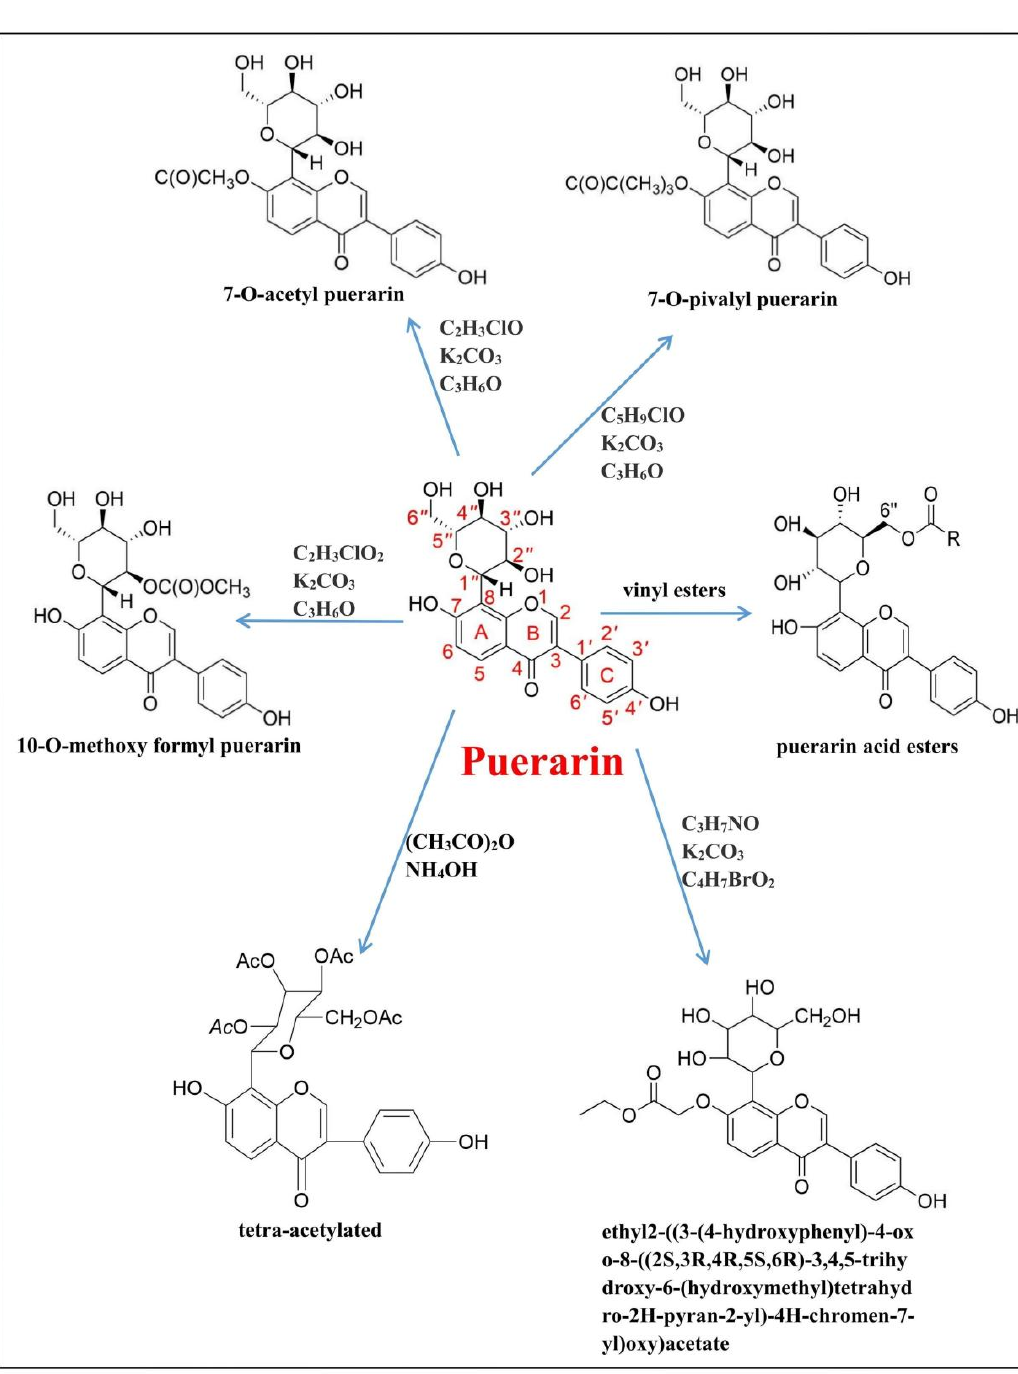
Figure 6. Chemical structures of a series of puerarin derivatives [137–143].